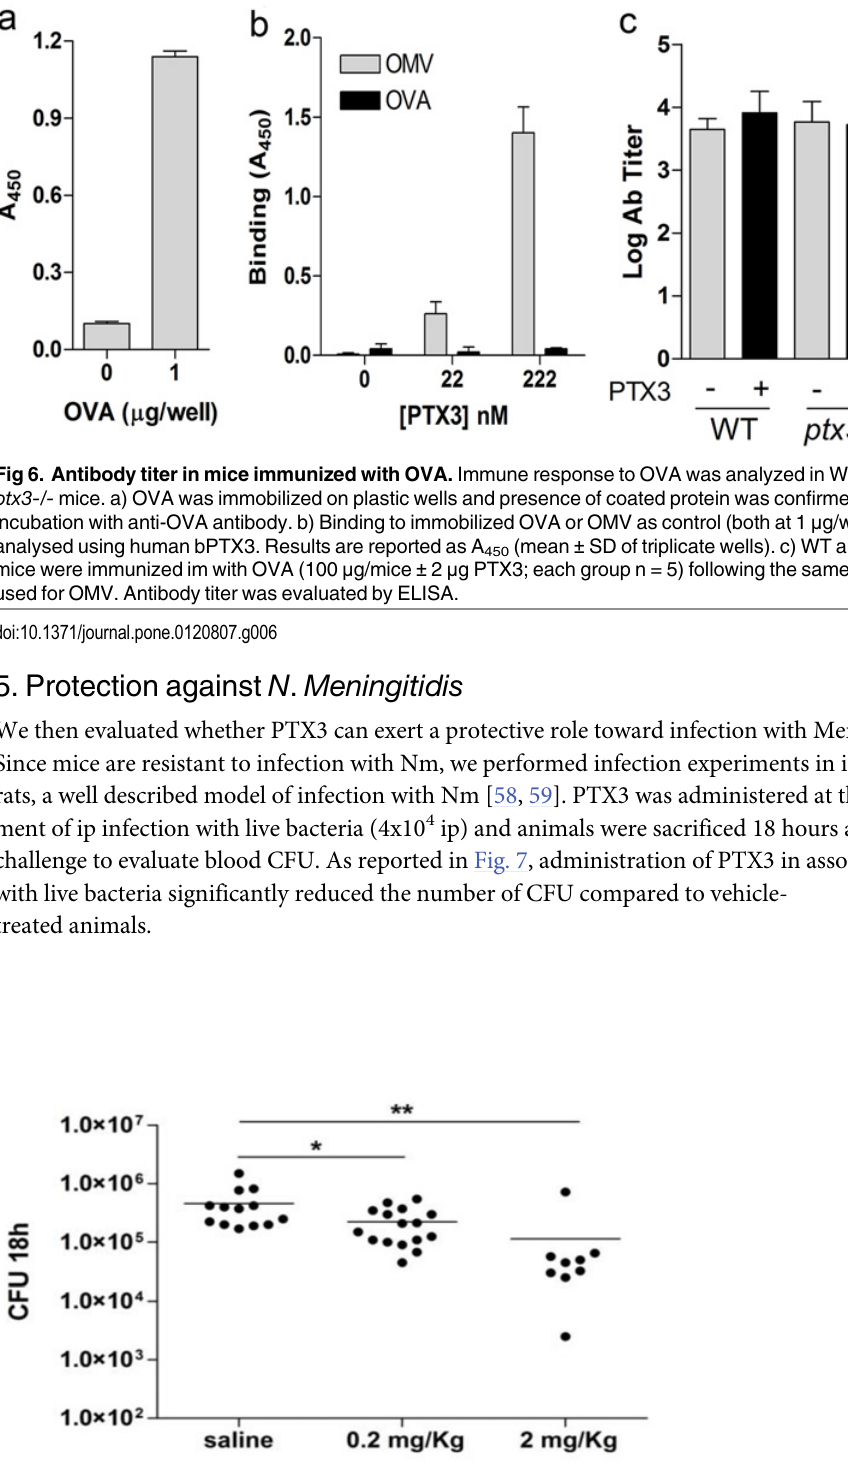
Fig 7. Protective effect of PTX3 in the infant rat model. Infant rats were infected ip with 4x10 4 CFU MenB strain 2996 in association with 0.2 or 2 mg/Kg of human recombinant PTX3 (n = 16 and n = 9 respectively) or vehicle (n = 13). Blood CFU were evaluated 18 hrs after challenge. * p < 0.05 (unpaired Student ’ s t